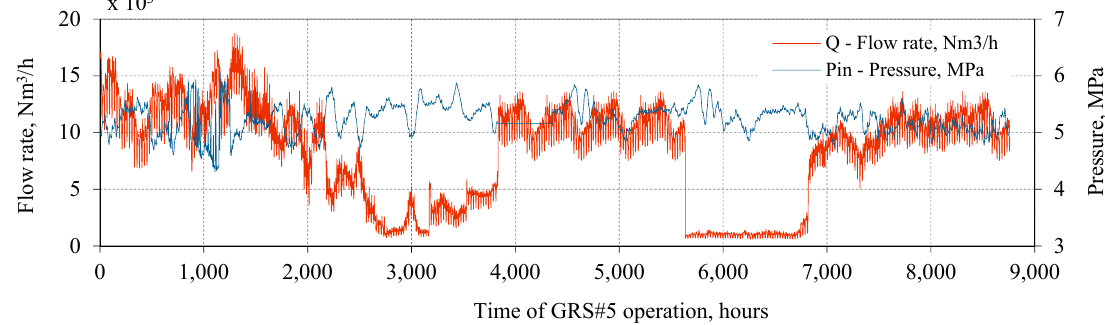
Figure 7. Natural gas flow and at pressure regulation stations GRS #5 (before expansion) over a period of one year.